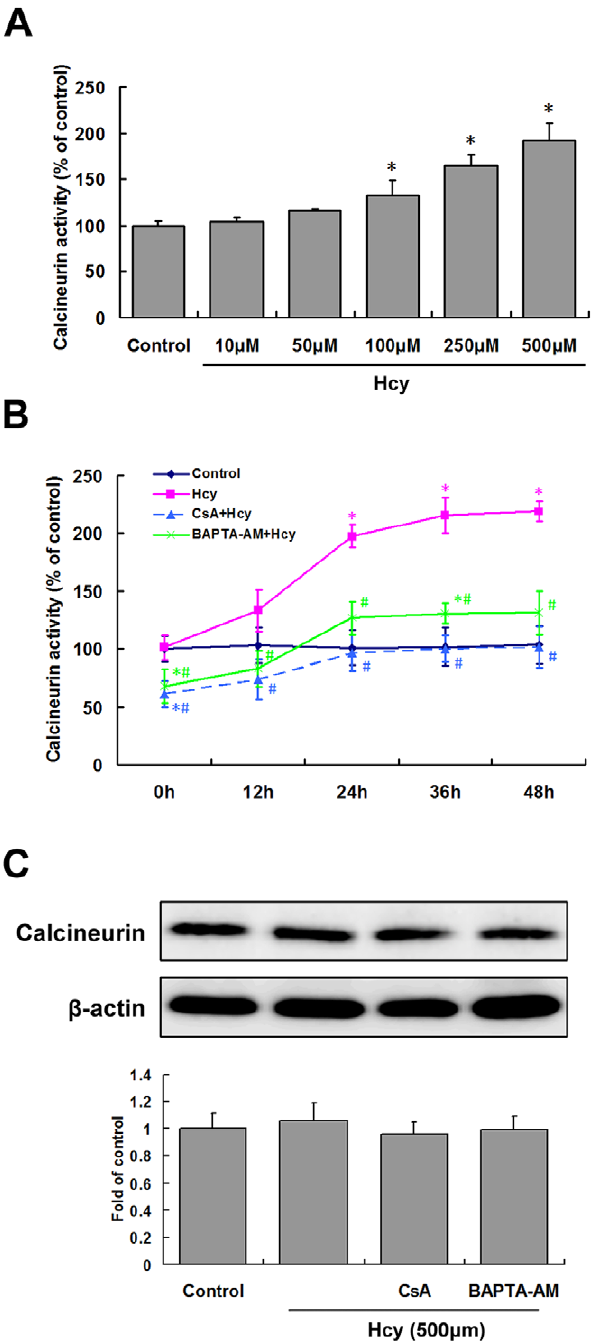
Figure 3. Activation of calcineurin by Hcy and inhibition by specific blockers. A, Cultures were exposed to the indicated concentrations of Hcy ( Hcy ) for 24 h, and cellular calcineurin activity was then determined. B, Cells were pretreated with 1 m M CsA or 10 m M BAPTA-AM for 30 min before exposed to 500 m M Hcy ( Hcy ). Cellular calcineurin activity was measured at the indicated time periods after the addition of Hcy to the cells. Values represents the mean 6 S.E.M. of four or more assays. C, Cells were pretreated with 1 m M CsA or 10 m M BAPTA-AM for 30 min before exposed to 500 m M Hcy ( Hcy ) for 24h. Calcineurin A (Calcineurin) protein level was determined by western blotting. Top, representative western blots. Bottom, densitometric analysis. * P , 0.05 vs. control. # P , 0.05 vs. Hcy treatment group.